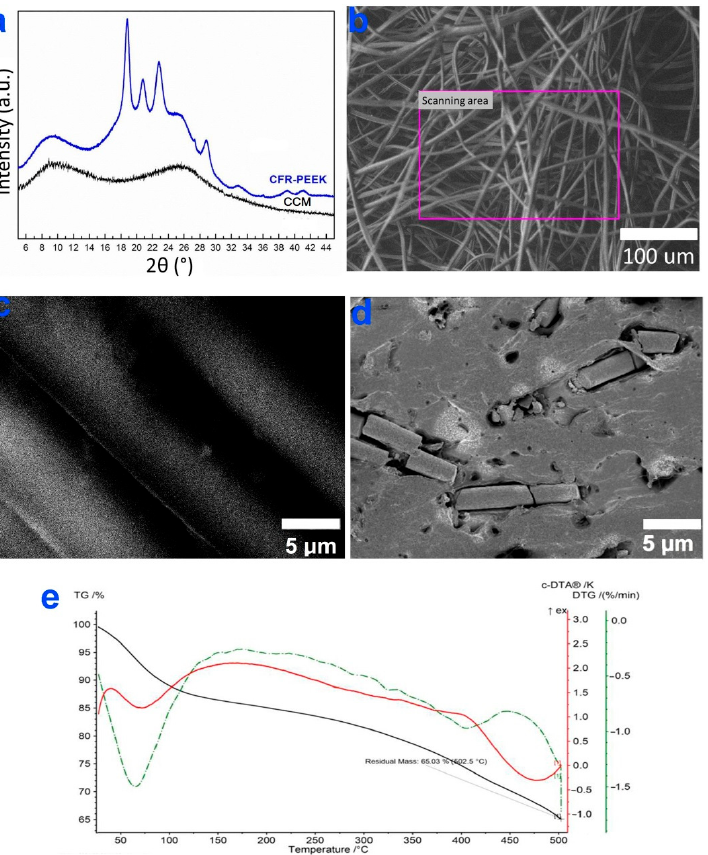
Figure 2. XRD patters of CCM and CFR-PEEK ( a ), SEM images of CCM ( b , c ) and CFR-PEEK ( d ), TG-DTA curves of CCM ( e ).